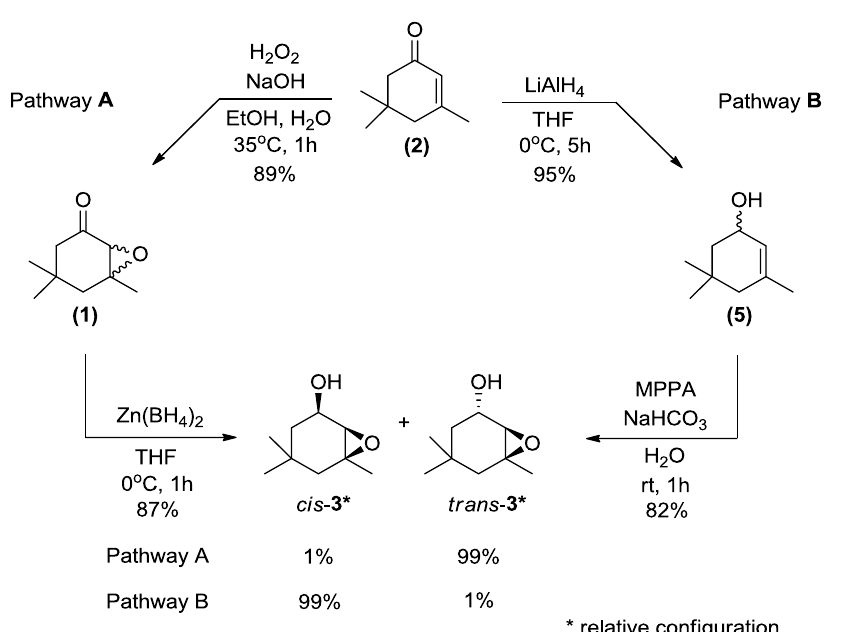
Figure 5. Synthesis of cis - 3 from pathway A: epoxidation of 2 followed by stereoselective reduction with zinc borohydride. Synthesis of trans - 3 from pathway B: reduction of the carbonyl of 2 , followed by stereoselective epoxidation of the double bond with